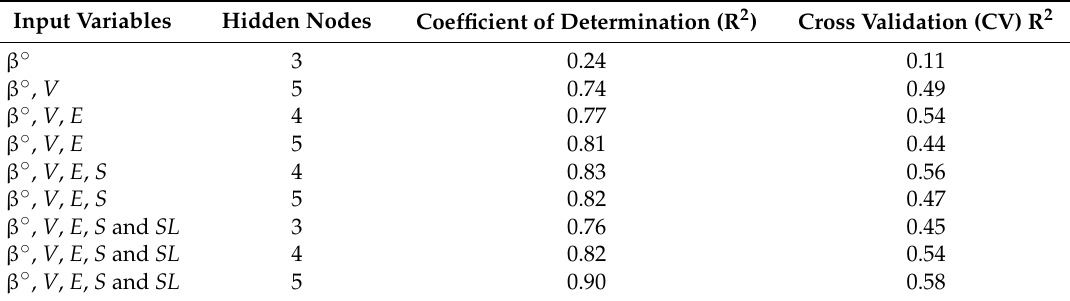
Figure 9. Neural networks based numerical models for soil moisture estimation in Nash Draw, NM, USA. Note: β° —Backscatter value; V —Vegetation; S —Soil type; E —Elevation; SL —Soil salinity. Table 3. Coefficient of determination (R 2 ) and cross validation coefficient of determination (CV R 2 ) of the neural networks based numerical models for soil moisture